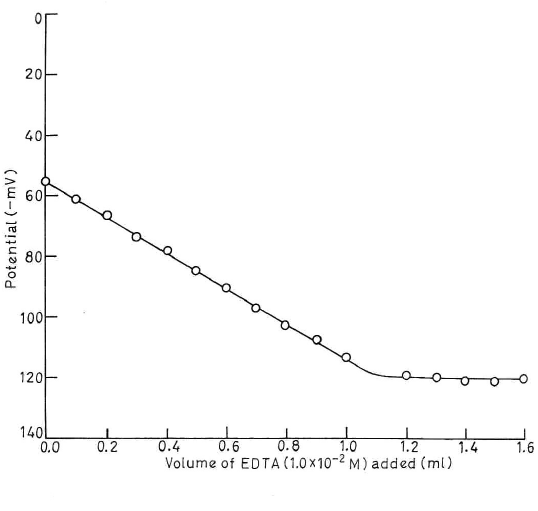
Fig.6 : Potentometric titration of Zn 2+ ions (1.0 · 10 -3 M, 10 ml) with EDTA (1.0 · 10 -2